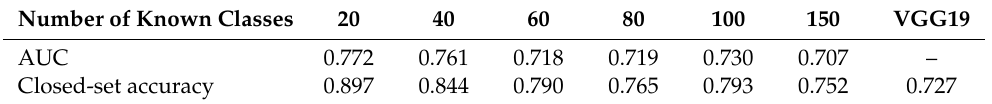
Table 4. OSR performance on ImageNet regarding AUC and closed-set accuracy with various numbers of known classes used for training. In all cases, every other class provided negative samples. The rightmost column shows the performance of the original VGG19 network on all 1000 classes.